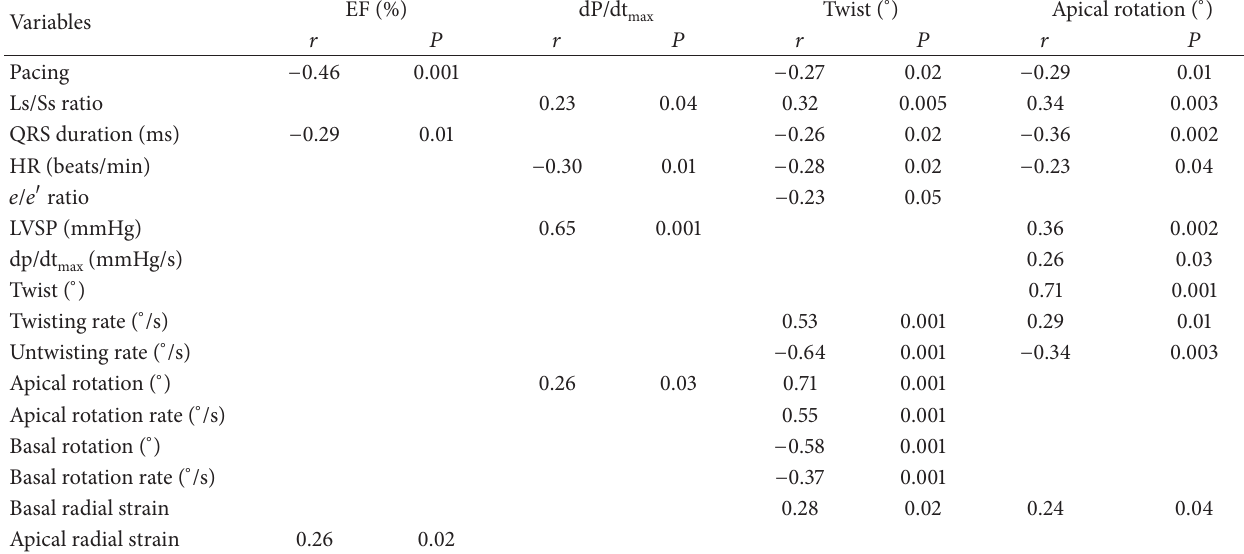
Table 3: Significant correlations between hemodynamic, torsional, and deformation indices in the overall study population. Variables